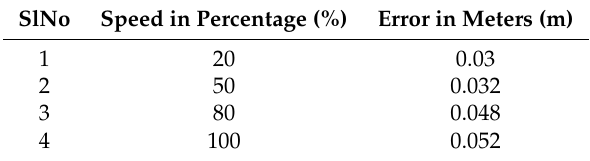
Table 1. Average positional error between encoder and beacon values at different